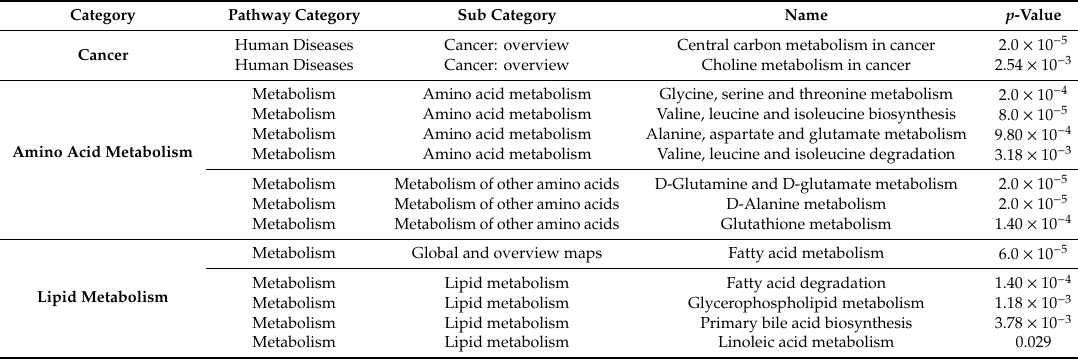
Table 3. Significant pathways, within specific categories and subcategories, related to